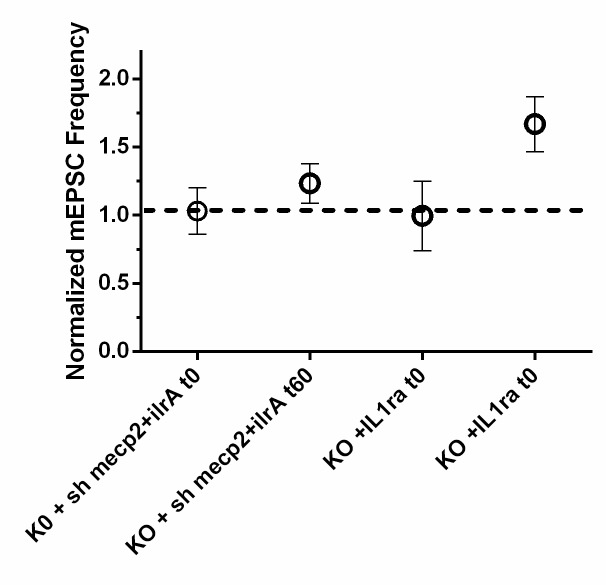
DOI:
http://dx.doi.org/10.7554/eLife.21735.020